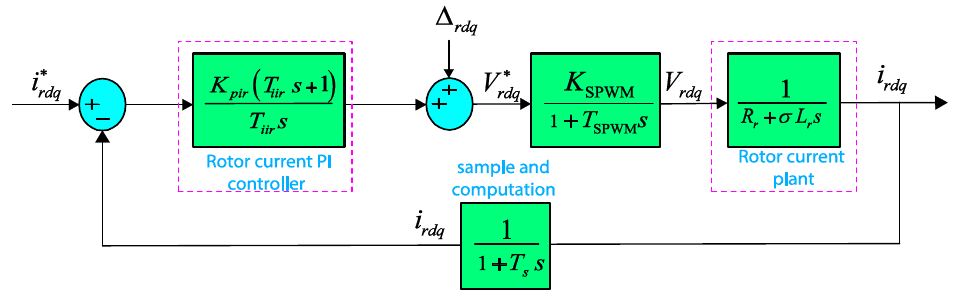
Figure 2. Proportional-Integral ( PI) control scheme for the inner current loop of the RSC.